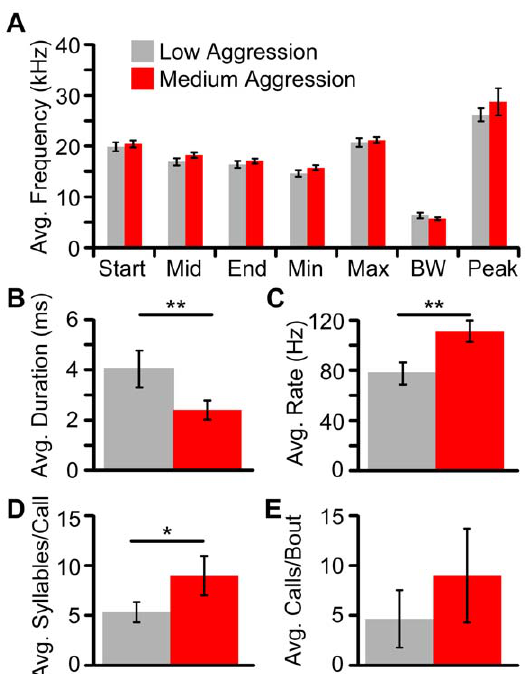
Figure 5. Medium aggression reveals a distinct call structure. ( A ) DFMs syllables do not show spectral differences between low aggression ( grey ) or medium aggression ( red ) contexts. However, DFMs syllable duration was significantly shorter ( B ), syllables were emitted at a faster repetition rate ( C ), and there were more syllables per call ( D ) during medium aggression. Although not significantly different, the number of calls/bout tended to be greater during medium aggression bouts ( E ). Bars represent mean 6 2 standard errors. Asterisk, p , 0.01. Double asterisk, p , 0.001.